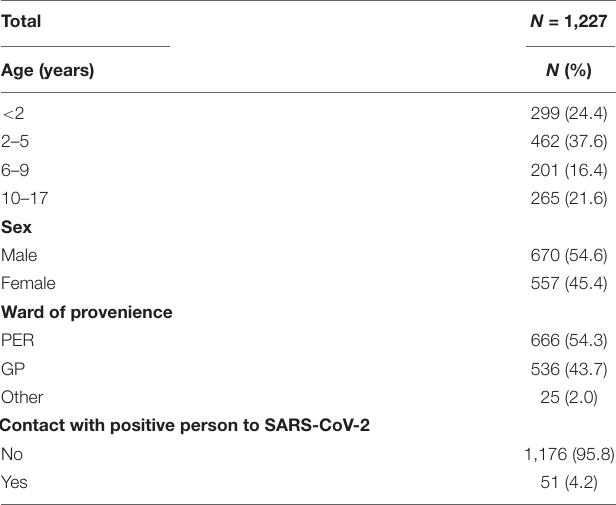
TABLE 1 | Characteristics of children enrolled in the